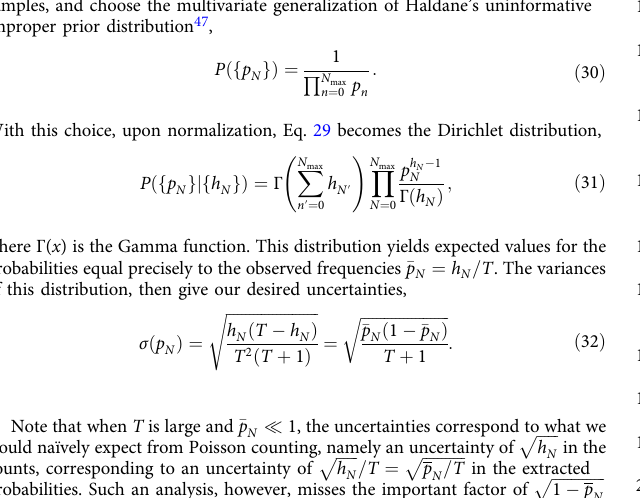
(cid:2) p (cid:2) p N ð 1 (cid:4) N